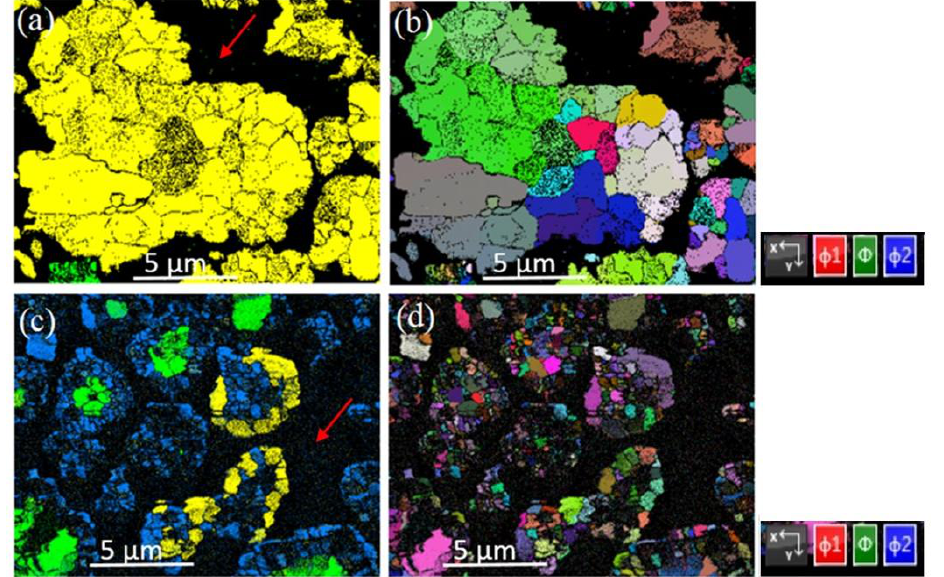
Figure 5. Electron back-scatter diffraction (EBSD) images of polished surfaces for Ni-B aggregates from Run 3 and Run 8. Red arrows indicate mounting resin. ( a ) EBSD map of the sample from Run 3 showing predominantly Ni 2 B (yellow) with minor Ni 3 B (green); ( b ) Euler map of the aggregate from Run 3 with polar orientations (right hand panel); ( c ) EBSD map of sample from Run 8 with three phases including Ni 2 B (yellow), Ni 3 B (blue) and Ni (green). ( d ) Euler map of the aggregates from Run 8.